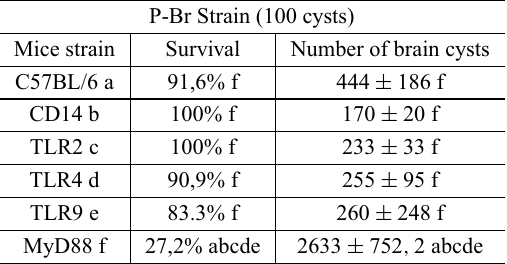
Number of brain cysts and survival of mice after per-oral infection with P-Br strain of T. gondii . P-Br Strain (100